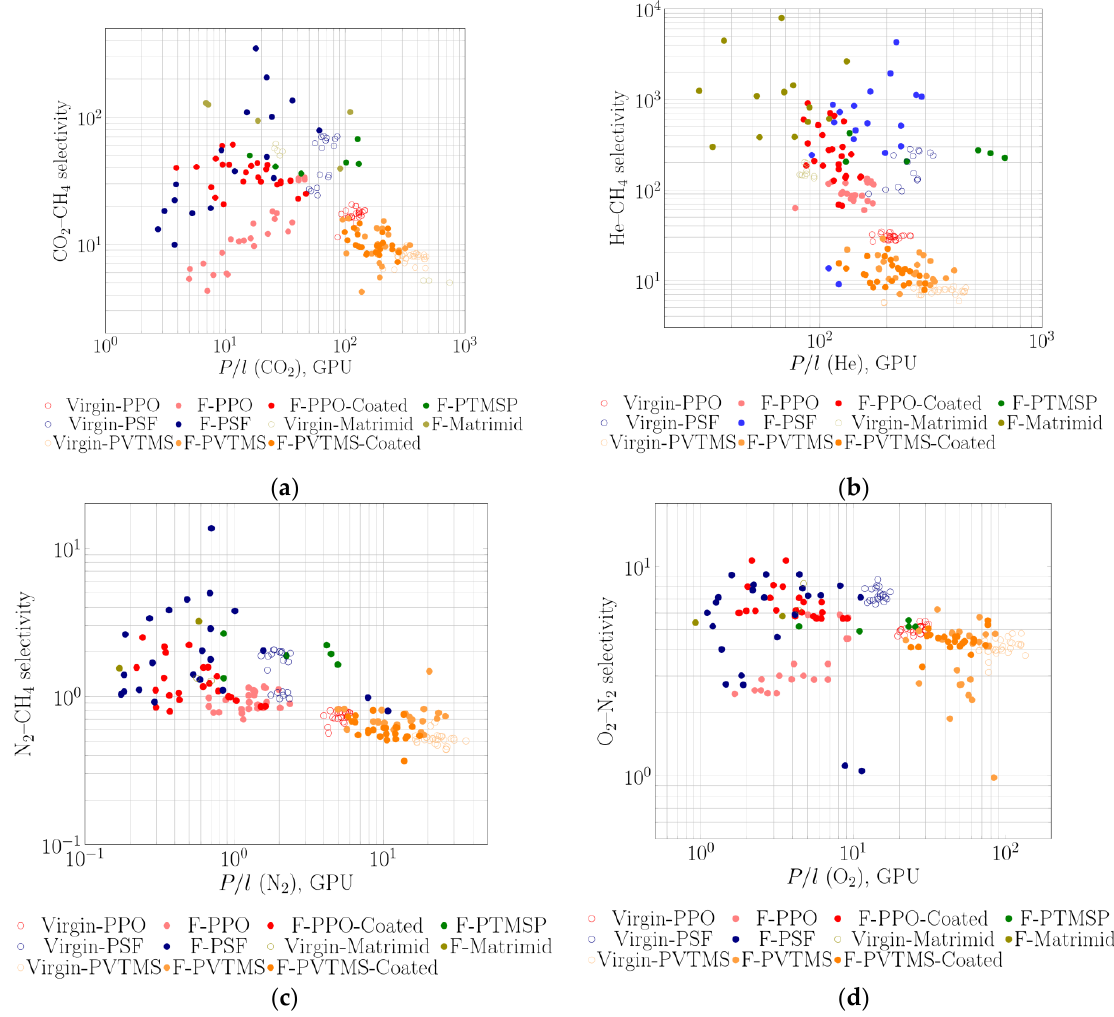
Figure 7. Plots of ideal selectivity of gas pairs CO 2 -CH 4 ( a ), He-CH 4 ( b ), N 2 -CH 4 ( c ) and O 2 -N 2 ( d ) vs. permeability for the virgin and treated with elemental fluorine and coated with PDMS membranes: PTMSP [58], PPO [60], PSF [69,93], Matrimid [72,73] and PVTMS